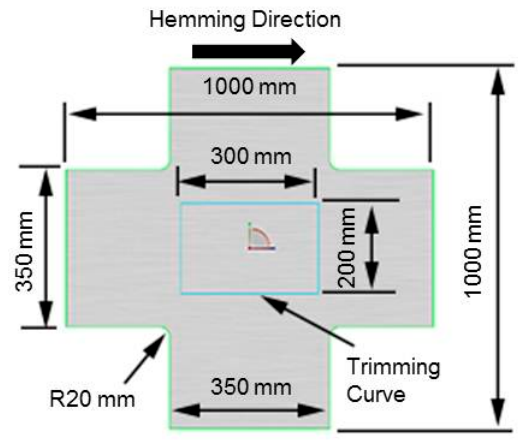
Figure 6. Original blank size before biaxial stretching and trimming size after biaxial stretching.